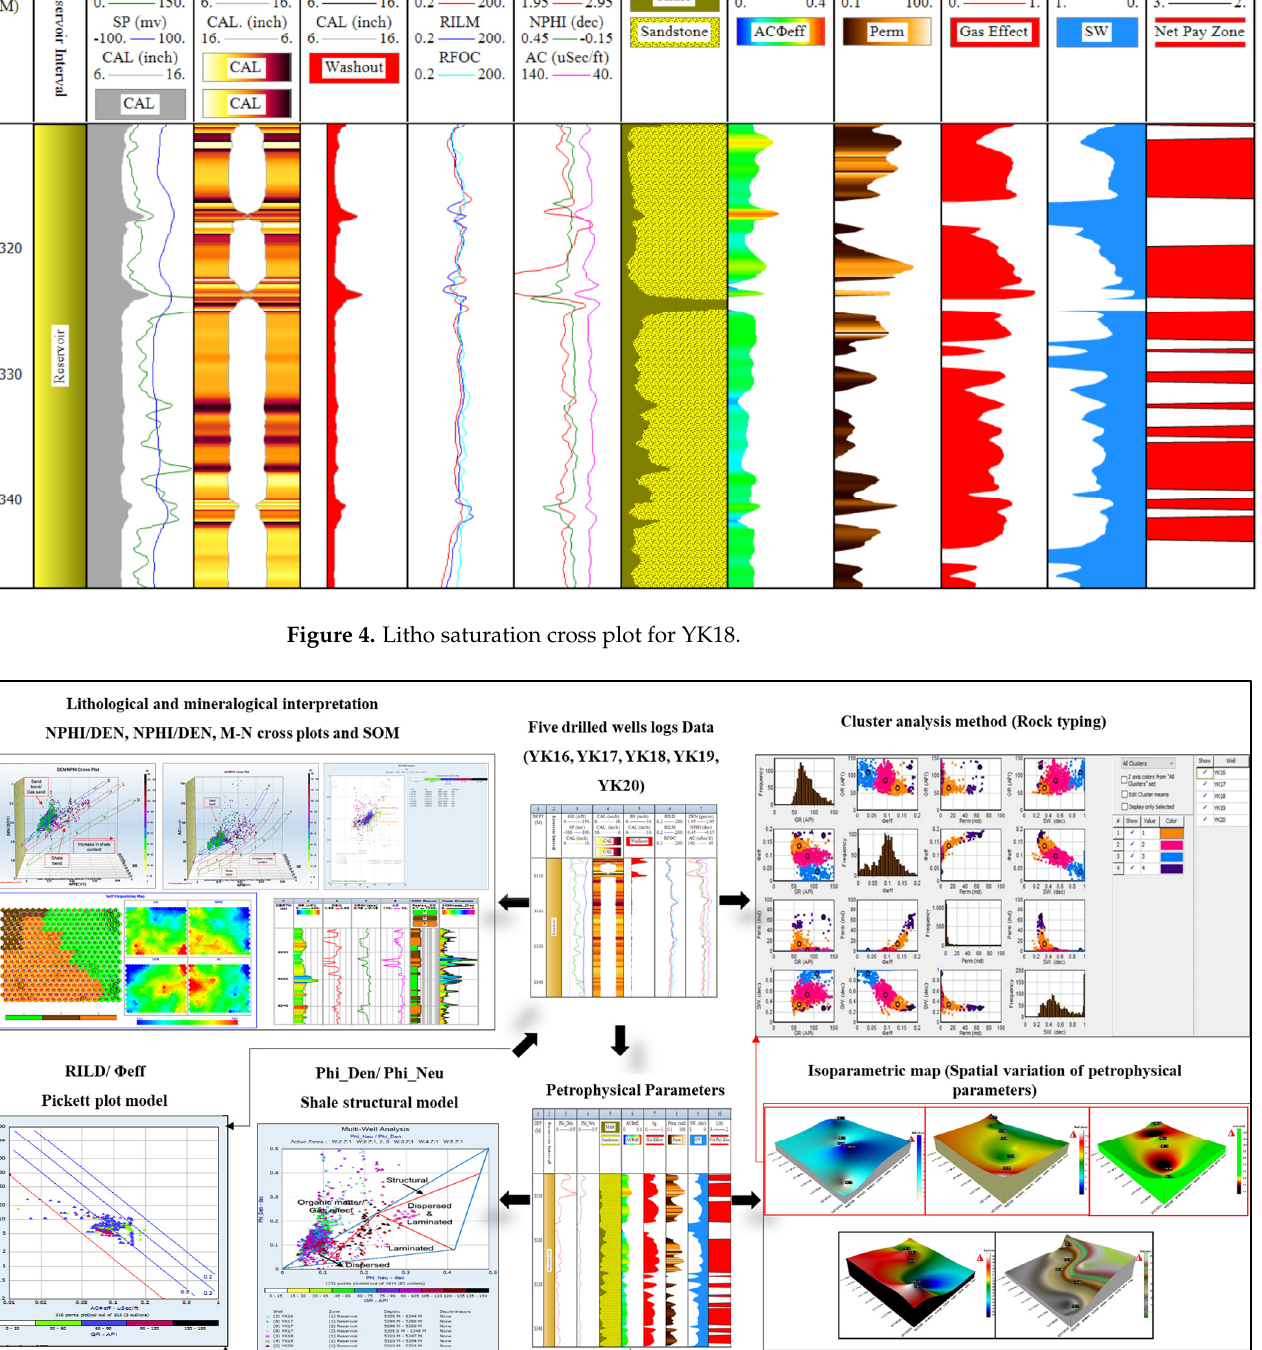
Figure 5. Workflow for analyzing and characterizing the study reservoir.